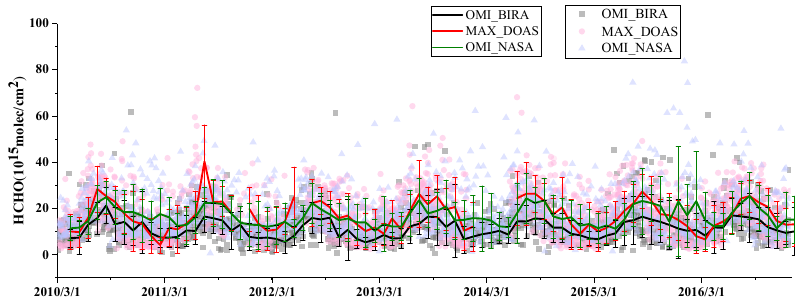
Figure 1. Location of Xianghe and the multi-year averaged formaldehyde (HCHO) over the North China Plain (2010–2016). Left : OMI-BIRA; right : OMI-NASA.